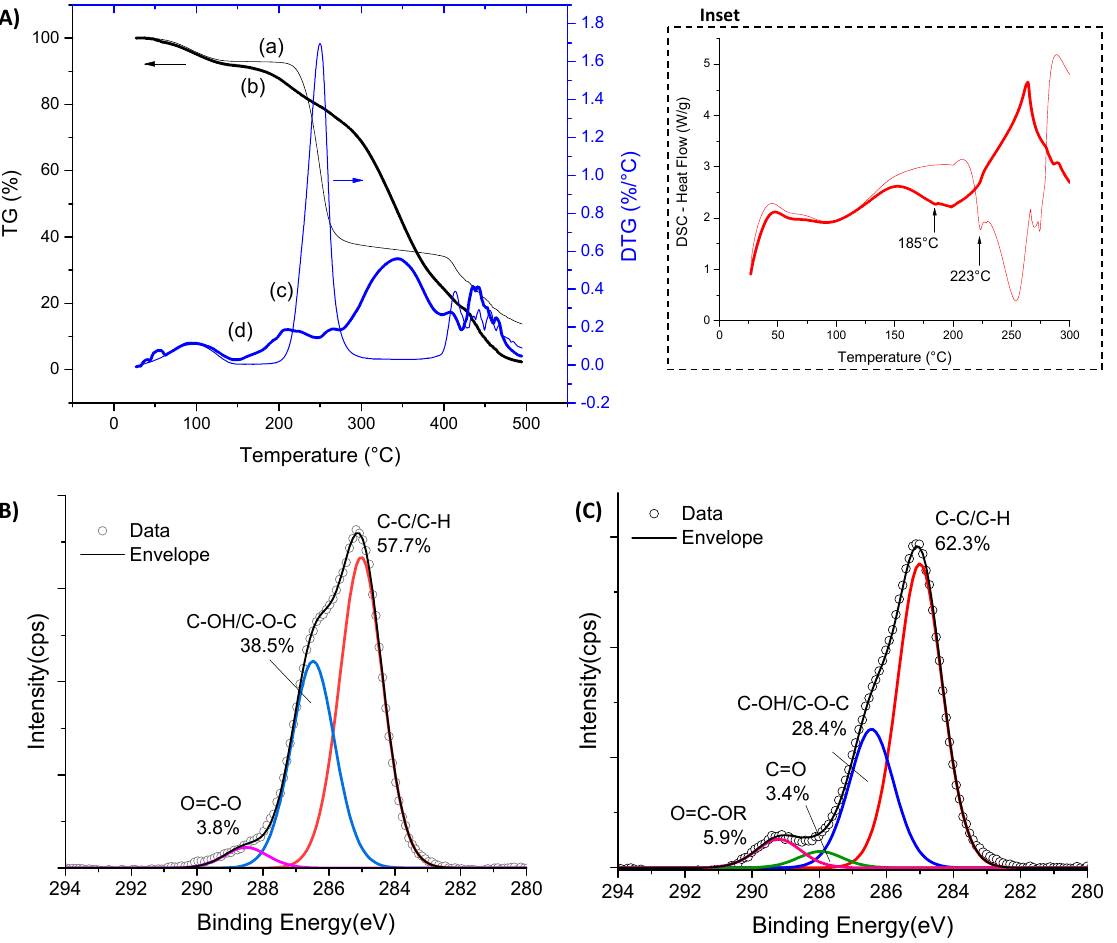
Figure 7. ( A ) TG ( a , b ) and DTG ( c , d ) analysis of PVA_CA0 (—) and PVA_CA25( — ) hydrogels (inset DSC curves). XPS analysis of C 1s region of ( B ) PVA_CA0 and ( C ) PVA_CA25 hydrogels.